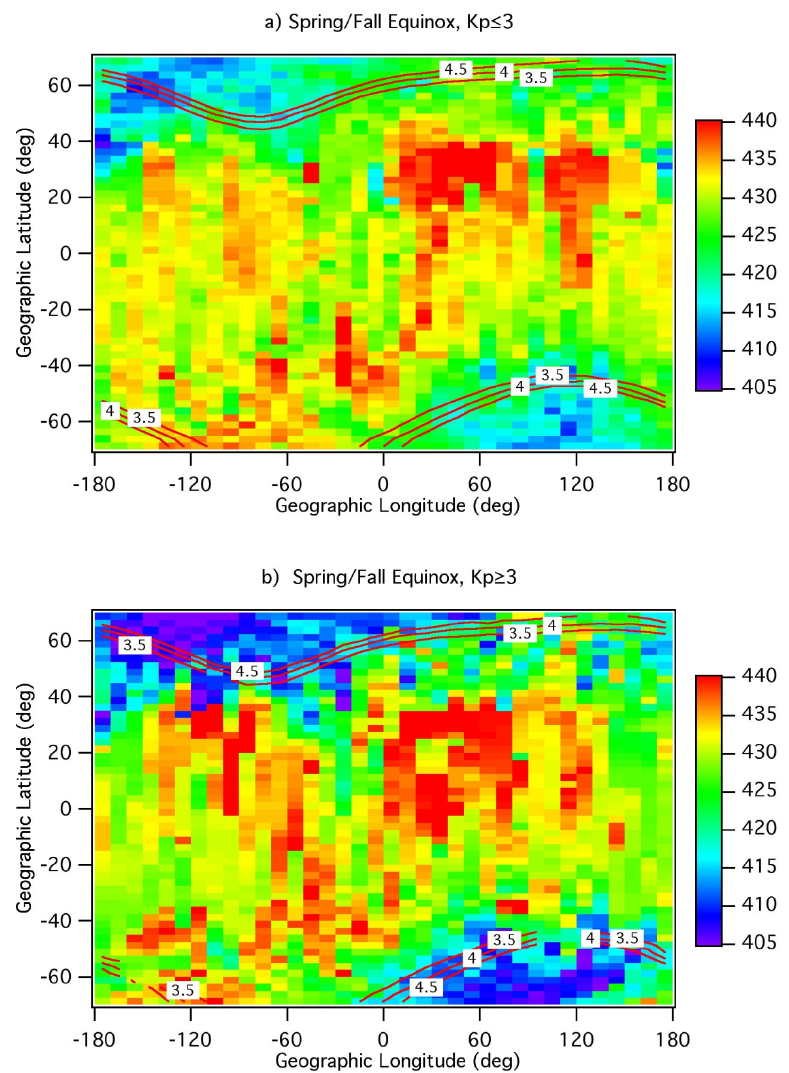
Fig. 5. AE-C: Maps of P -parameter for equinox (March, April, September, October) for (a) quiet magnetic conditions ( K p ≤ 3, above) and (b) disturbed magnetic conditions ( K p ≥ 3, below). Red curves show magnetic L